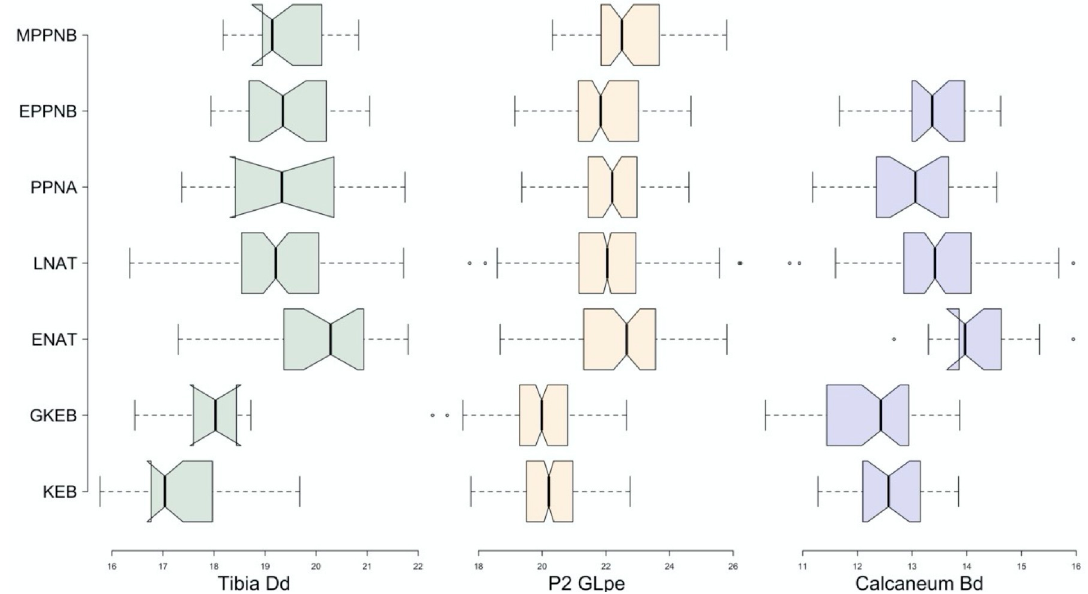
Fig 4. Notched boxplots indicating the range, mean and 95% confidence interval of the Dd of the tibia, GLpe of the second phalanx and the Bd of the calcaneum for each of the seven archaeological phases in our study. See Table 1 for sample sizes for each element.